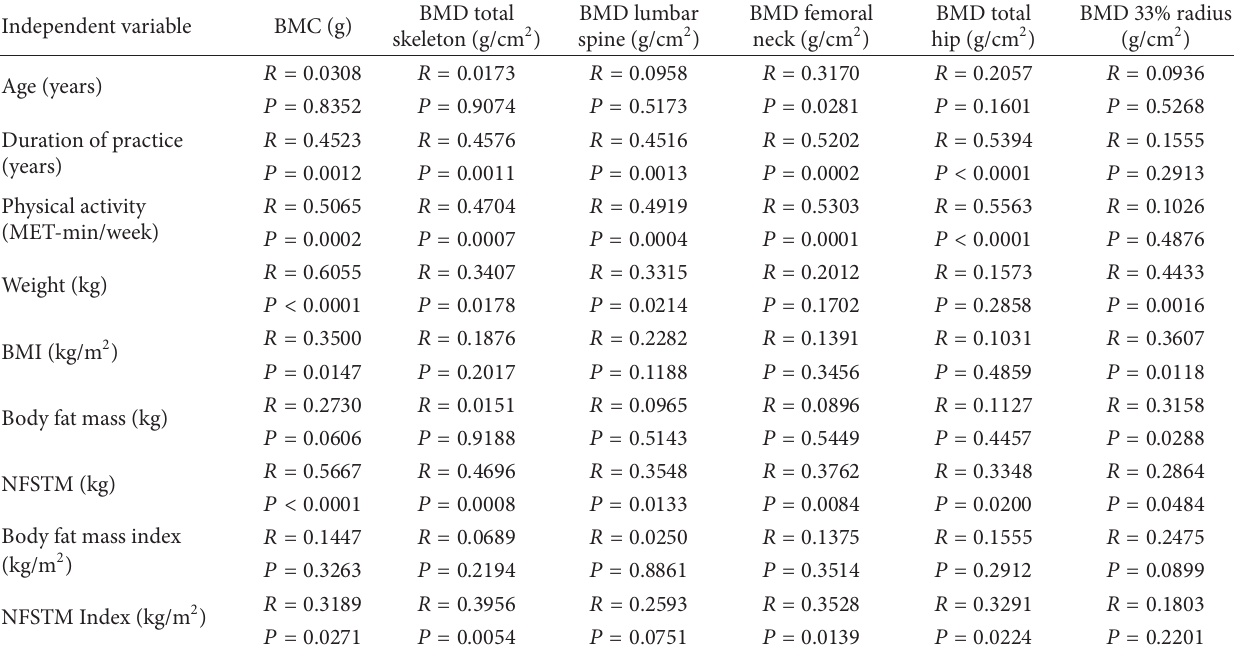
Table 4: Simple linear regression results for all three groups ( 𝑛 = 48